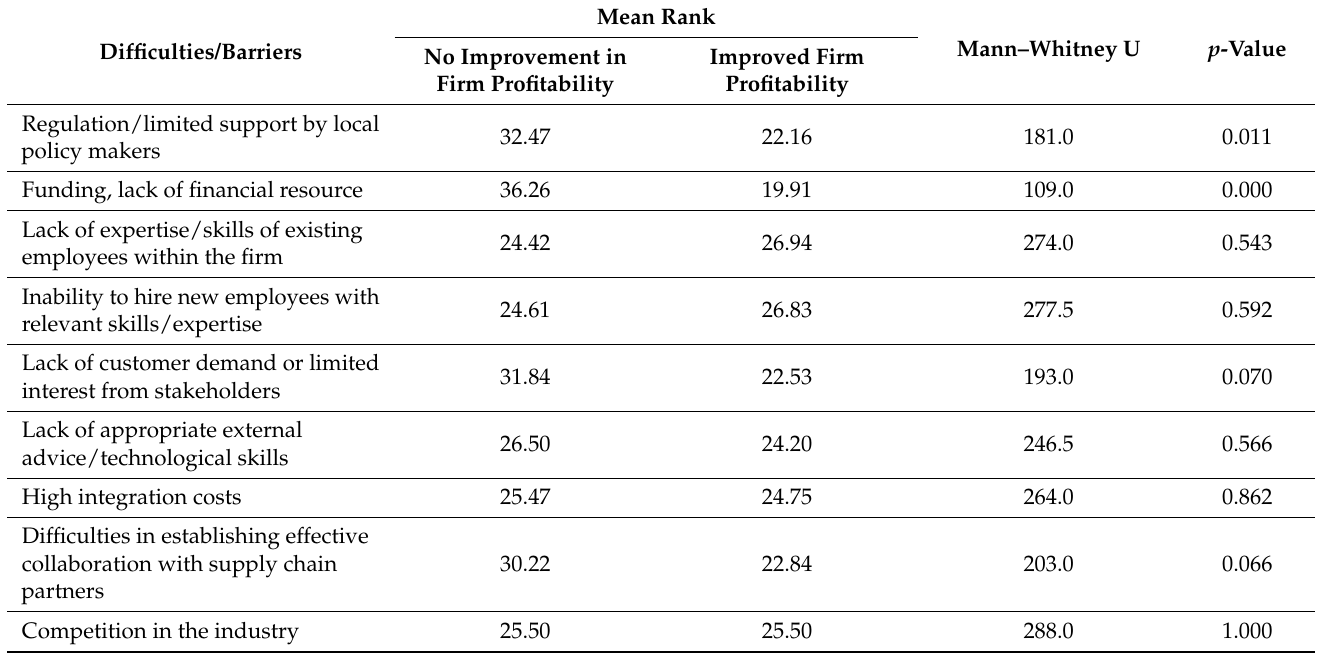
Table 6. Difficulties/barriers of rural SMEs during the adoption/integration of new technology—firm profitability.